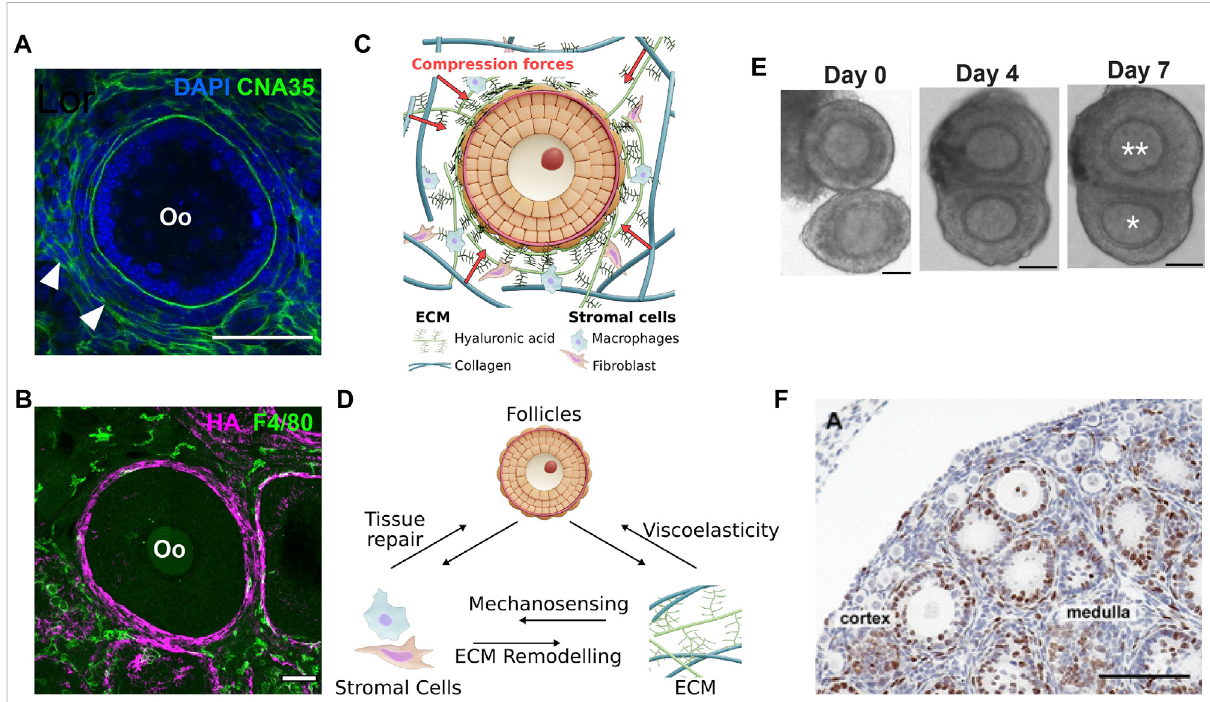
FIGURE 3 Stromal mechanics and inter-follicle dynamics in ovary development. (A) . Labelling of CNA35, a collagen-binding protein, shows the presence of basement membrane within the follicle and at the interstitial tissue (white arrowhead). Scale bar: 50 μ m. (B) . Macrophages labelled with F4/ 80wereobservedattheinterstitialmatrix,whilethehyaluronicacid(HA)washighlyexpressedattheTClayer.Scalebar:50 μ m. (C) .Growingfollicles maybemechanicallycon fi nedbythesurroundingECMthatcomprisesmainlyofcollagenandHA. (D) .Potentialfeedbackinteractionsbetween stromal cells, ECM and follicle growth during ovarian development and ageing. Changes in ECM composition and mechanical properties may activate immune response from macrophages via mechanosensing pathways, or the stromal cells may actively remodel the ECM or participate in tissue repair during follicle death or post-ovulation. Changes in ECM viscoelastic properties may directly in fl uence follicle growth. ( E – F) . Follicle- follicle interactions may provide additional mechanical signals to in fl uence follicle growth. (E) . In vitro culture of follicle doublet shows that the follicles can merge over the course of 7 days to generate a dominant, growing follicle (double asterisks) and a ” subordinate ” follicle with limited growth (single asterisk). Scale bar: 50 μ m. (F) . Evidence of close contact among pre-antral follicles in a P12 mouse ovary. Scale bar: 100 μ m. Image from (Da Silva-Buttkus et al.,